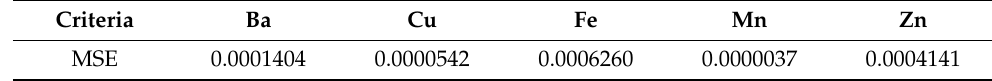
Table 7. Spot Sampling Comparison